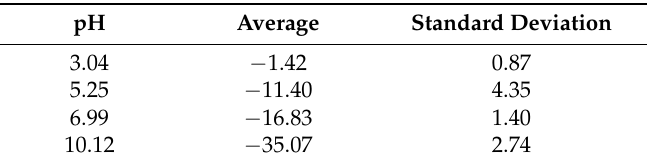
Table A1. Average size of carbon dots, under varying pH levels, while maintaining a constant ion concentration of 10 mM